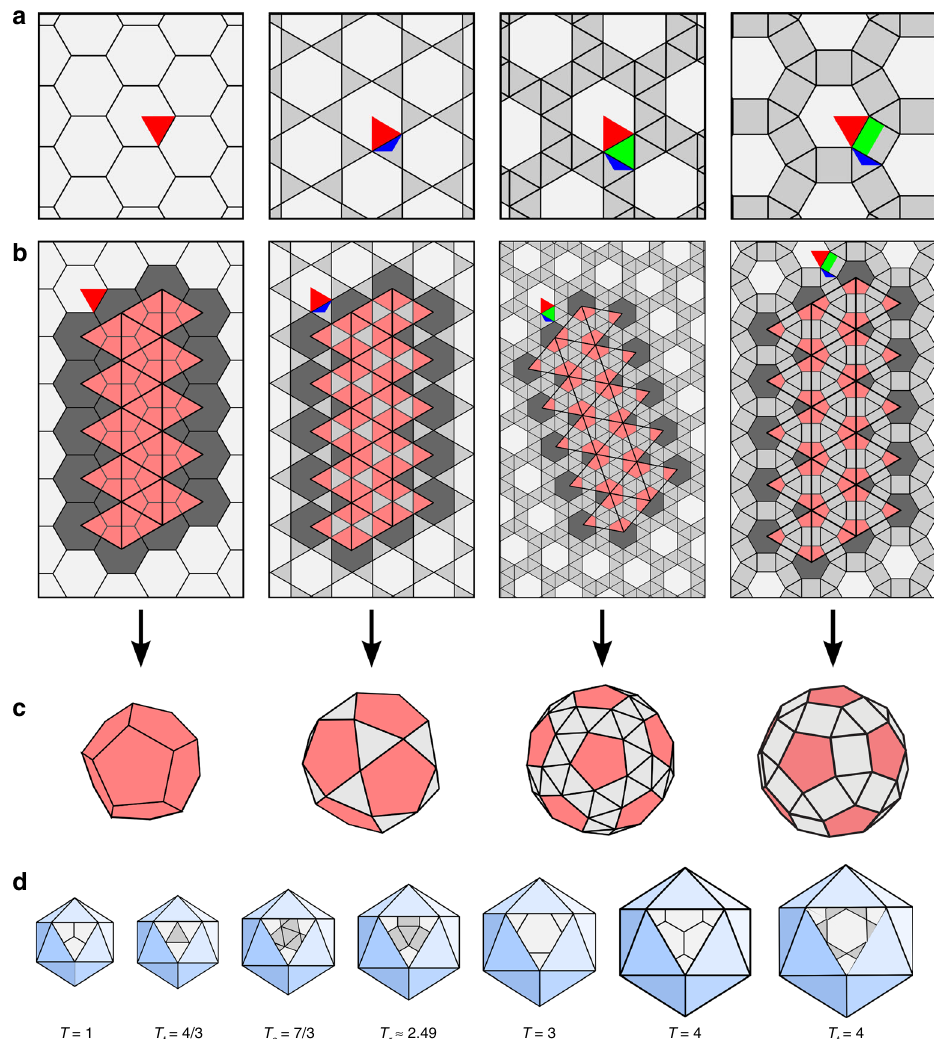
Fig. 2 Design of icosahedral architectures from Archimedean lattices. a The four Archimedean lattices permitting the Caspar-Klug construction (from top to bottom): the hexagonal ð 6 ; 6 ; 6 Þ , the trihexagonal ð 3 ; 6 ; 3 ; 6 Þ , the snub hexagonal ð 3 4 ; 6 Þ , and the rhombitrihexagonal ð 3 ; 4 ; 6 ; 4 Þ lattice. In each case, the asymmetric unit (repeat unit of the lattice) is highlighted. Its overlap with the hexagonal sublattice used for the construction of the icosahedral polyhedra is shown in red. Apart from the case of the hexagonal lattice, this also includes a third of a triangular surface (blue), and in addition a triangle or a half square (both shown in green) for two of the lattices, respectively. b Construction of Archimedean solids via replacement of 12 hexagons by pentagons in analogy to the Caspar-Klug construction (see also Fig. 1b). c The polyhedral shapes corresponding to the examples shown in b . They each correspond to the smallest polyhedron in an in fi nite series of polyhedra for the given lattice type. Folded structures for larger elements in the new series are provided in Supplementary Fig. 2. d The smallest polyhedral shapes ( T t , T s and T r , denoting polyhedra derived from the trihexagonal, snub hexagonal and rhombitrihexagonal lattices, respectively) are shown organised according to their sizes in context with the Caspar-Klug polyhedra. As surface areas scale according to Eq. (2) with respect to the Caspar-Klug geometries, the new solutions fall into the size gaps in between polyhedra in the Caspar-Klug series, or provide alternative layouts for capsids of the same size, as is the case for T ð 2 ; 0 Þ ¼ T t ð 1 ; 1 Þ ¼ 4 = 3 T ð 1 ; 1 Þ ¼